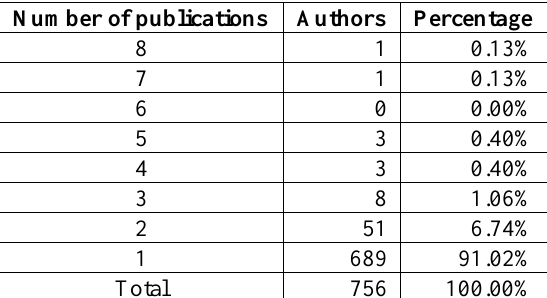
Table 10. Distribution of publications per